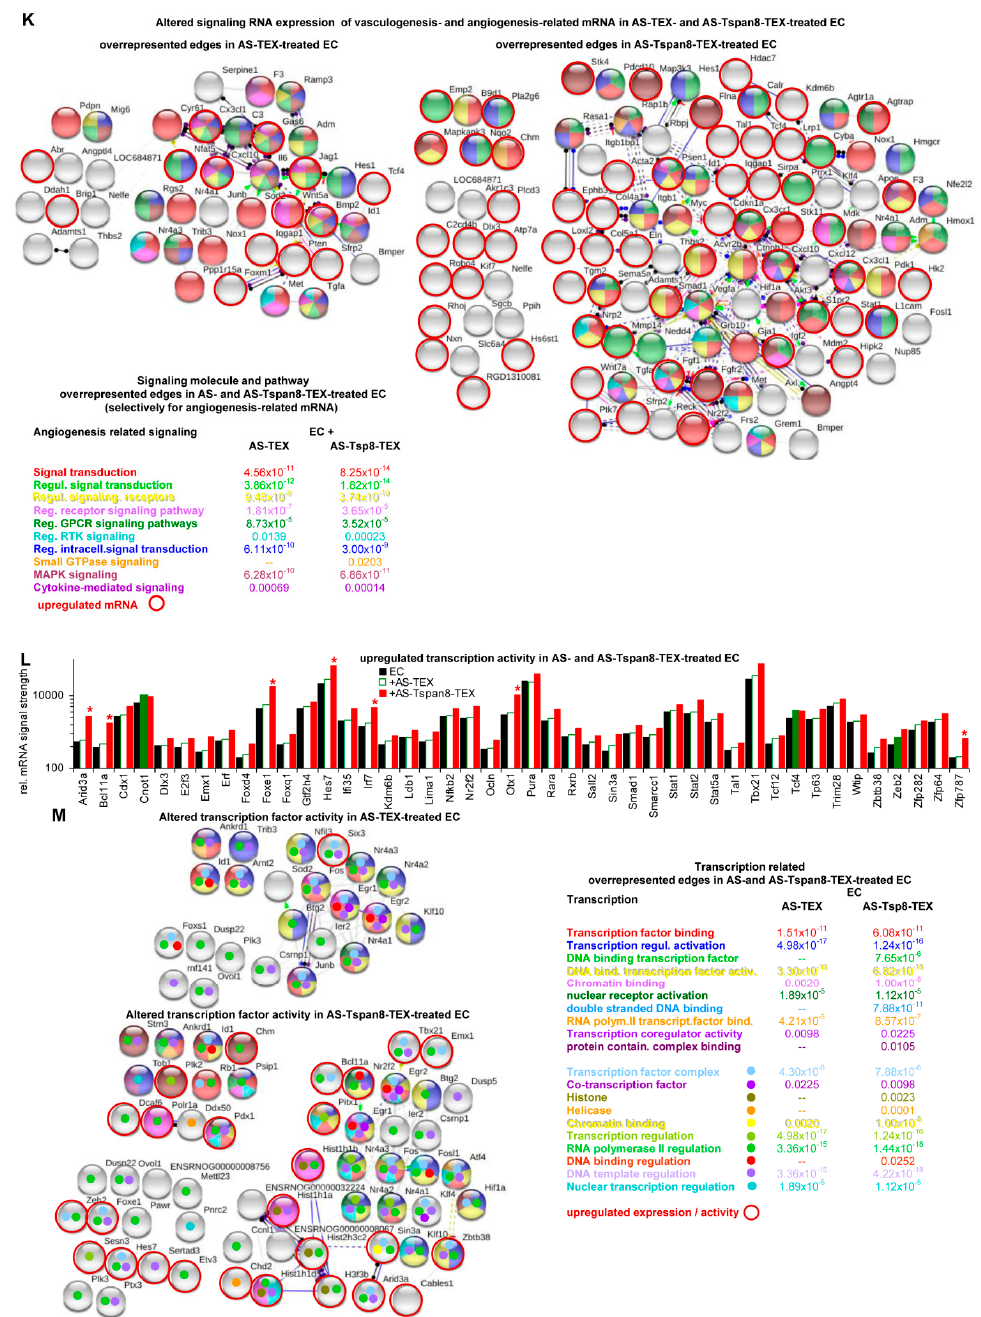
Figure 5. Angiogenesis-related mRNA modulation and associated signaling activation in TEX-treated endothelial cells. ( A ) EC were cultured for 48 h in matrigel in the presence of AS- or AS-Tspan8-TEX (30 µg/mL). Growth and spriting was evaluated by light microscopy (scale bar: 20 µm); ( B ) clusters of mRNA (STRING functional protein analysis) of AS-Tspan8-TEX-treated EC and indication of overrepresented edges according to UniProt Keywords; ( C ) protein array of chemokines, cytokines, growth factors, receptors, adhesion molecules, and proteases of AS- and AS-Tspan8-TEX-treated EC. Signal strength of duplicates was evaluated by imageJ and is presented adjusting signal strength of EC = 1. The signal strength particularly of cytokines being very low, only > 3-fold changes between untreated vs. AS- or AS-Tspan8-TEX-treated EC were considered as significant: *. ( D ) Western blot (WB) of